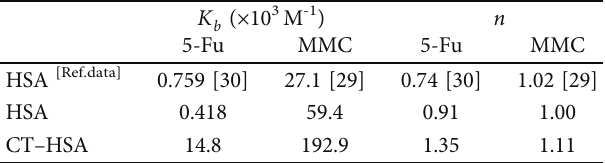
n ) Table 1: Binding constant ( K b ) and number of binding sites ( between 5-Fu or MMC and HSA, CT –